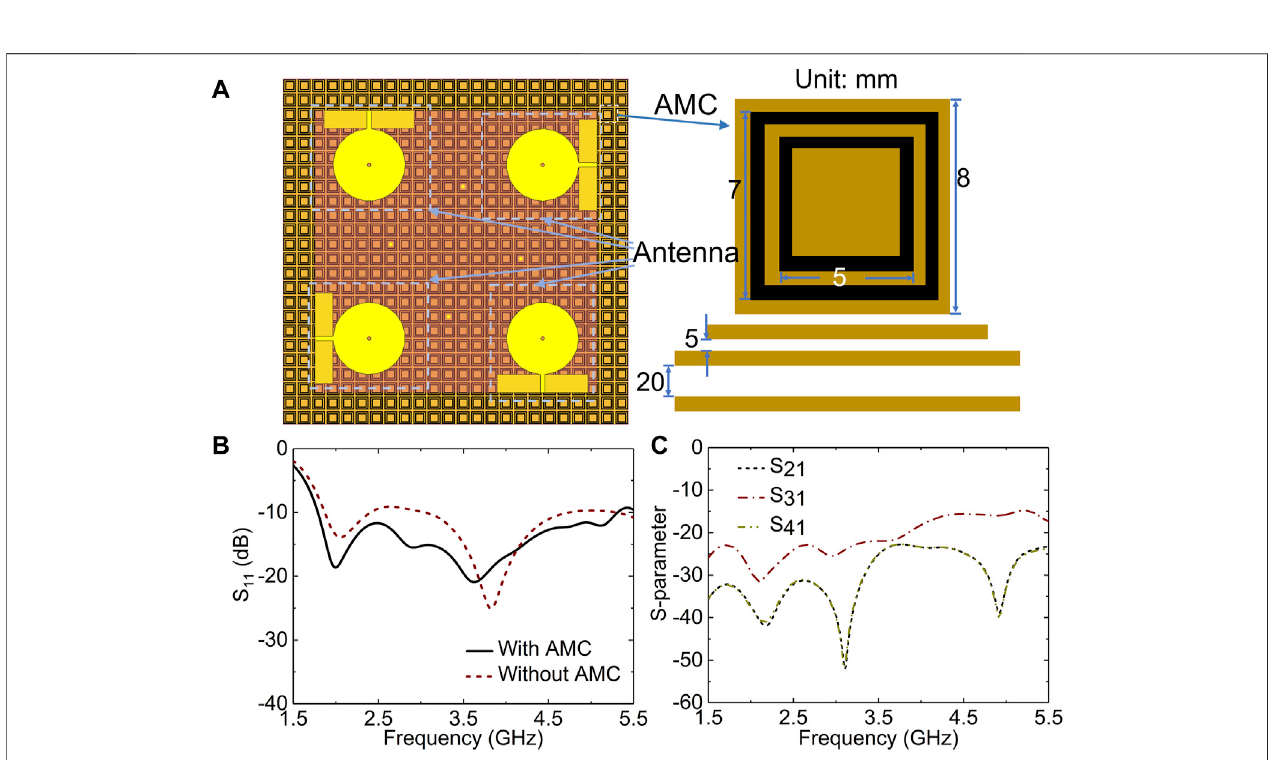
FIGURE 4 | (A) Geometry of the proposed antenna array. (B) Simulated re fl ection coef fi cient of the antenna with and without AMC structure. (C) Simulated S 21 , S 31 , S 41 of the antenna